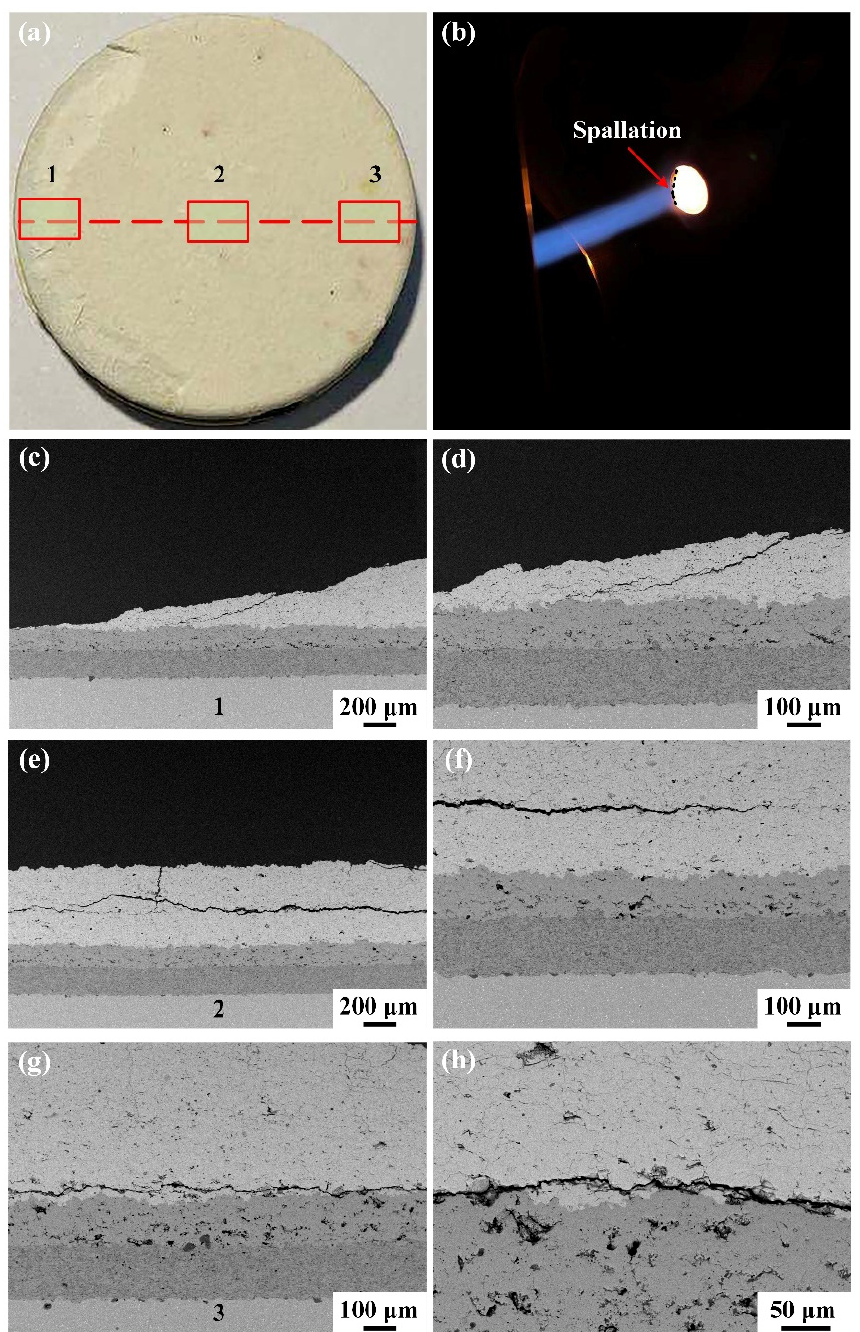
Figure 8. Macroscopic morphologies of the GSZC coating ( a ) after thermal shock and ( b ) during thermal shock, and cross-sectional morphologies of ( c , d ) area 1, ( e , f ) area 2, and ( g , h ) area 3.